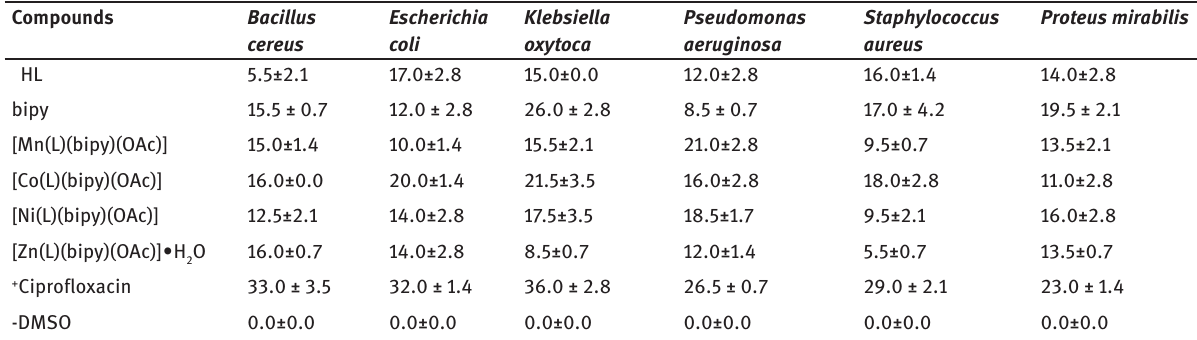
Table 4: Antibacterial data of ligand ( HL ) and the metal(II) complexes. Compounds